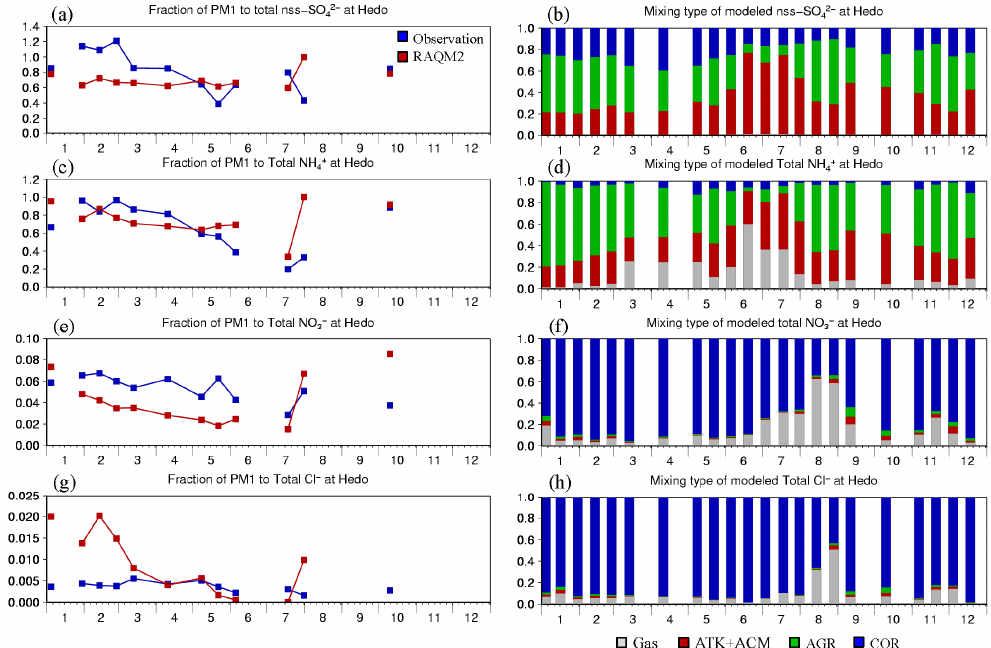
Fig. 6. (Left) Biweekly mean PM 1 to total (gas plus aerosol) concentration ratios and (Right) the modeled fractions of gas phase (grey), Figure 6. (Left) biweekly mean PM ATK + ACM category (red), AGR category (green), and COR category (blue) aerosols of (a–b) nss-SO 2 − (Right) the modeled fractions of gas phase (grey), ATK+ACM category (red), AGR category 3 (g–h) T-Cl − at (green), and COR category (blue) aerosols of (a)-(b) nss-SO 42- , (c)-(d) T-NH 4+ , (e)-(f) T-NO 3- , 4 and (g)-(h) T-Cl - at Hedo. 5